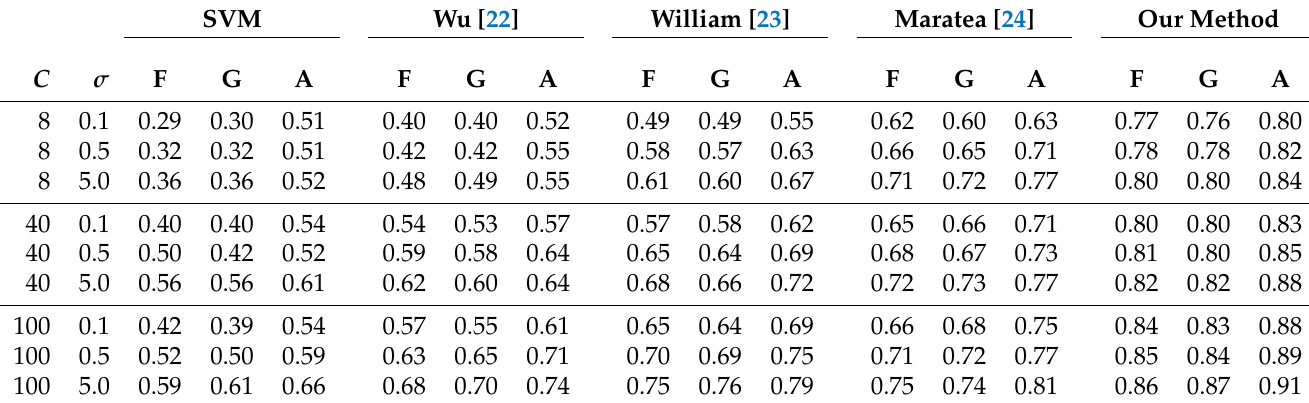
Table 2. F -score (F), G -mean (G) and the AUC (A) measures for all five classification methods in Scenario 2 for n 1 = 100, n 3 = 200 and n 3 = 300, respectively. Max margin is 0.04.